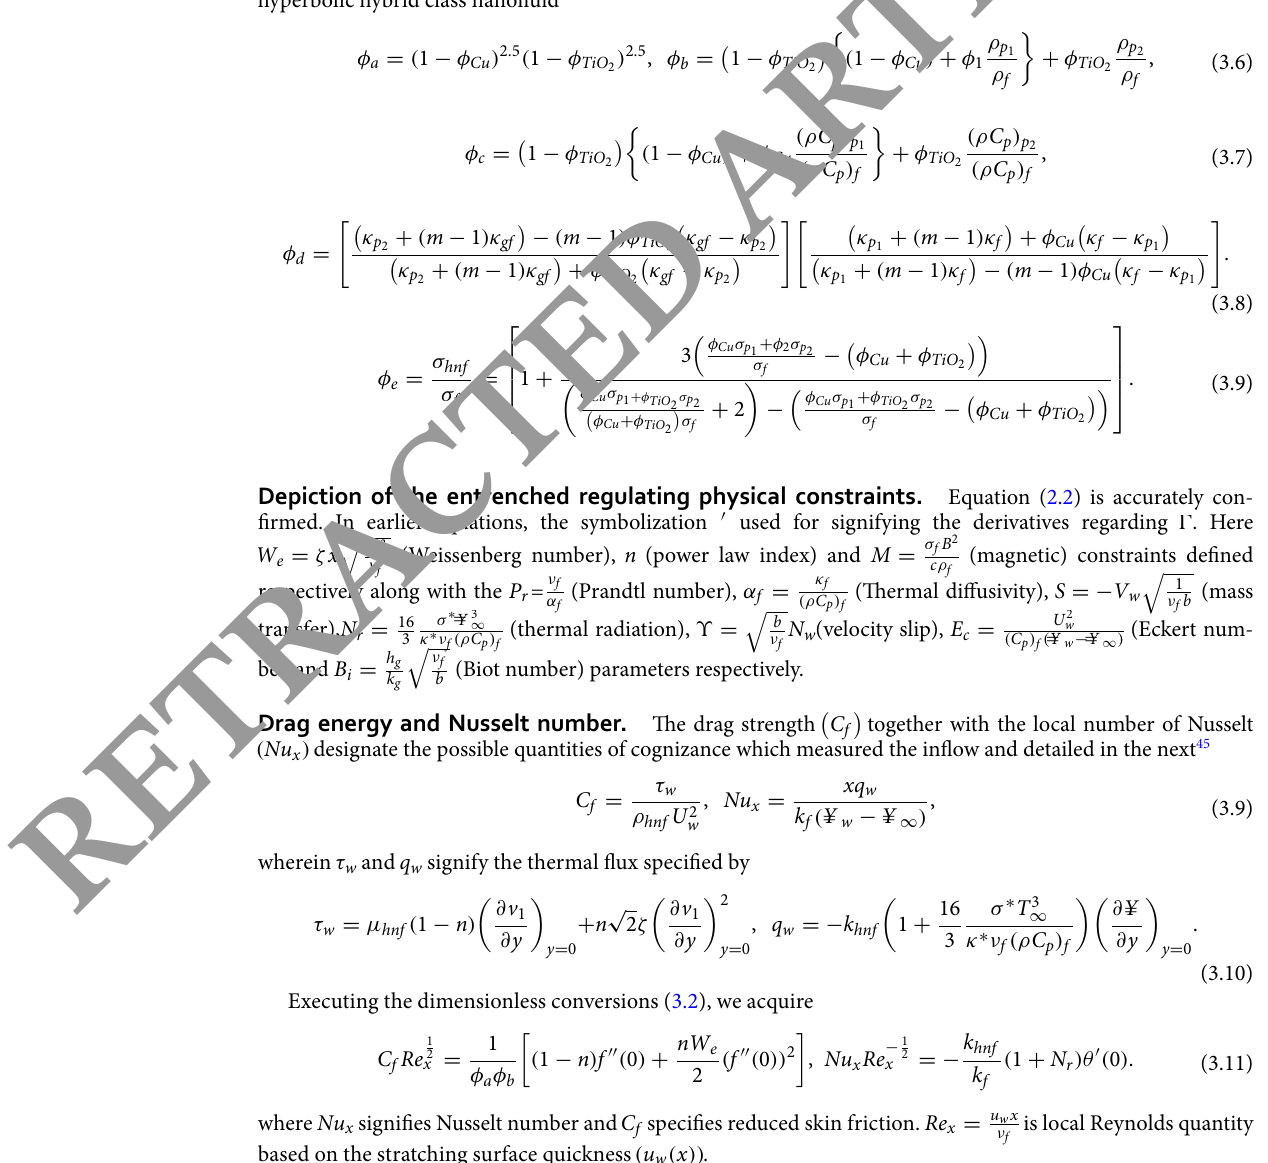
where Nu x signifies Nusselt number and C f specifies reduced skin friction. Re x based on the stratching surface quickness ( u w ( x ))